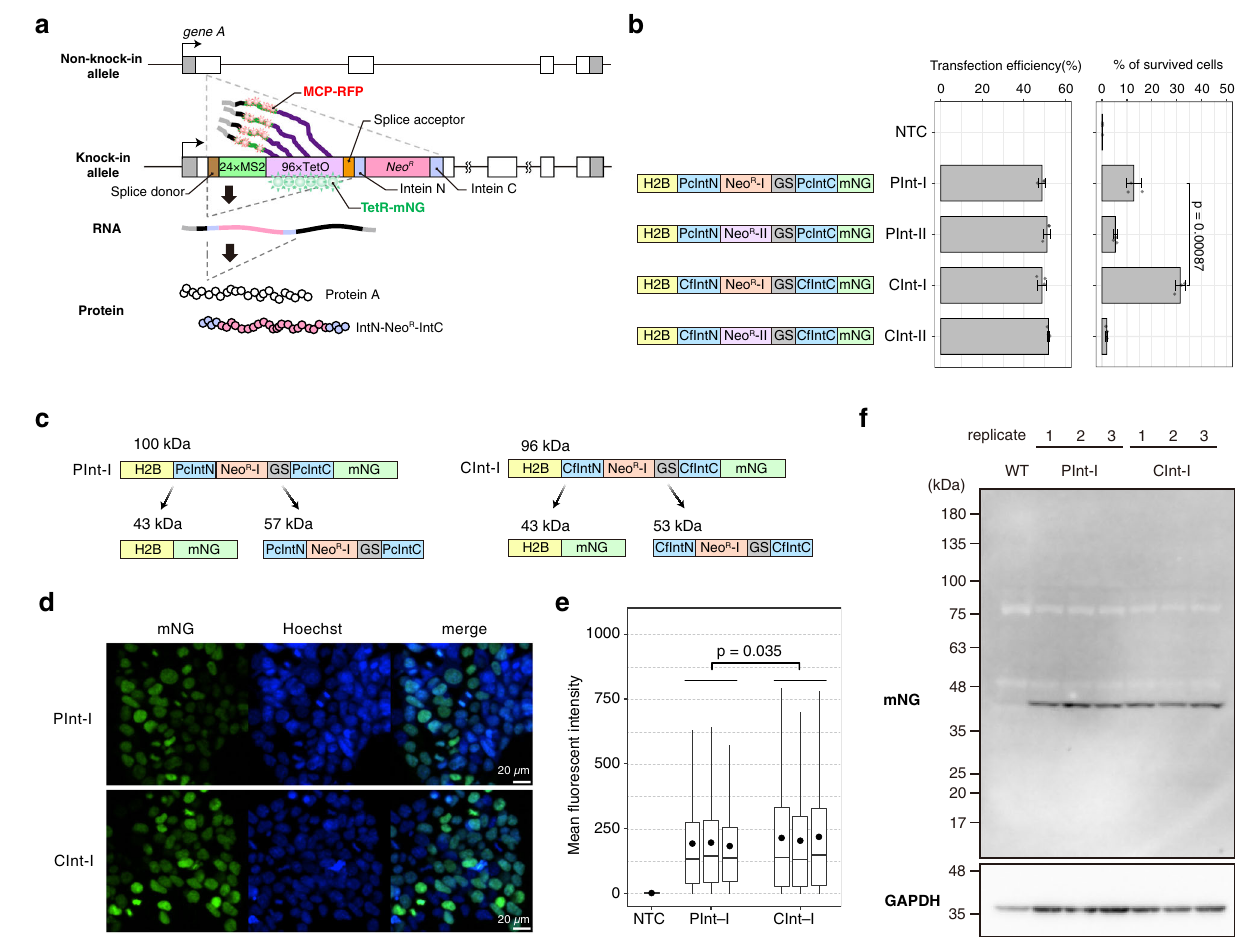
Fig. 1 | Optimization of selection markers fl anked by split inteins. a Molecular structure and design of the STREAMING-tag. 24×MS2, 24× Sirius MS2 repeat; 96×TetO,96× optimizedTetOrepeat. b Expressionvectorscontaining splitinteins with Neo R that encode G418 resistance protein were introduced into cells. The transfection ef fi ciency and the percentage of cells that survived G418 selection weremeasured.Dataarepresentedasthemeansofthreebiologicalreplicates,and errorbarsindicatestandarddeviations. P -valuescorrespondtounpaired,two-sided Student ’ s t -test.GS,GSlinker;NTC,notransfectioncontrol. c Theoreticalstructure and size of PInt-I and CInt-I. d Fluorescent images of PInt-I and CInt-I cells estab- lished after G418 selection in b . mNeonGreen (mNG) and Hoechst stained nucleus images (both images are maximum intensity projections of confocal sections) are